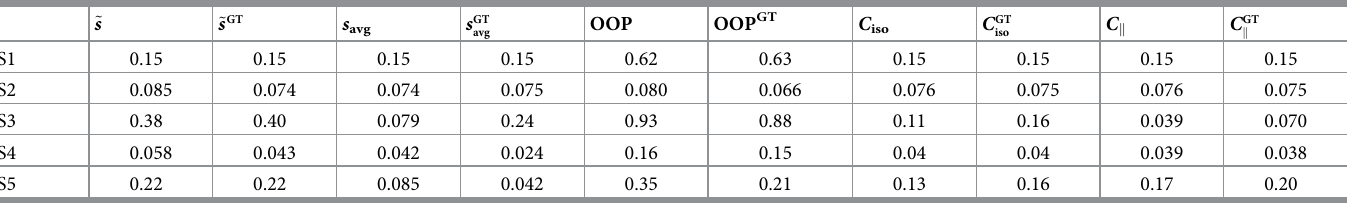
Table 2. Comparison of Sarc-Graph computed ~ s , s avg , OOP, C iso , and C k with the ground truth values of these parameters for each synthetic data example. ~